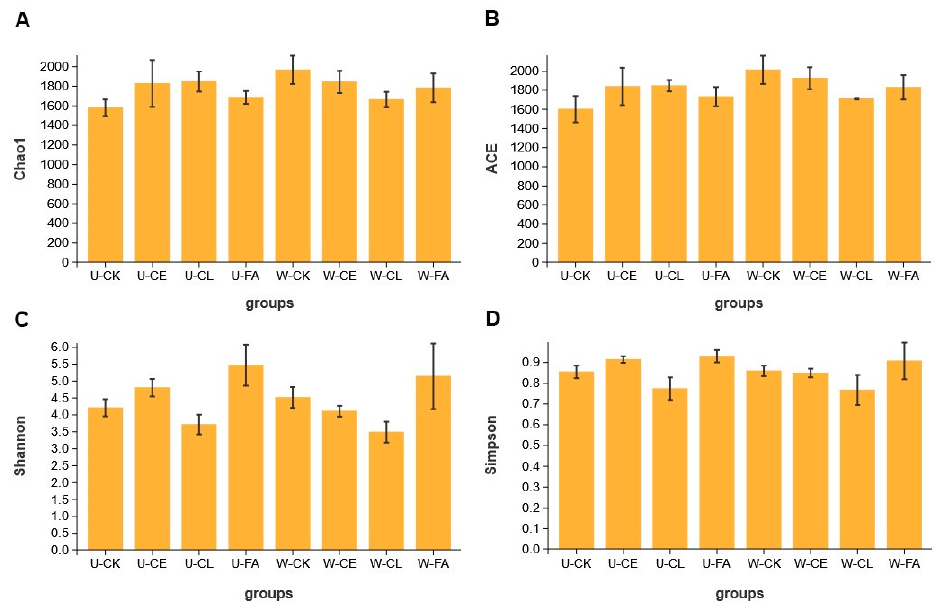
Figure 2. Alpha diversity of bacterial diversity at the Chao1 index ( A ), ACE (abundance-based coverage estimator) index ( B ), Shannon index ( C ), and Simpson index ( D ). U, wilt 0 h; W, wilt 3.5 h; CK, control (no additives); CL, Enterococcus durans ; CE, cellulase; and FA, formic acid.